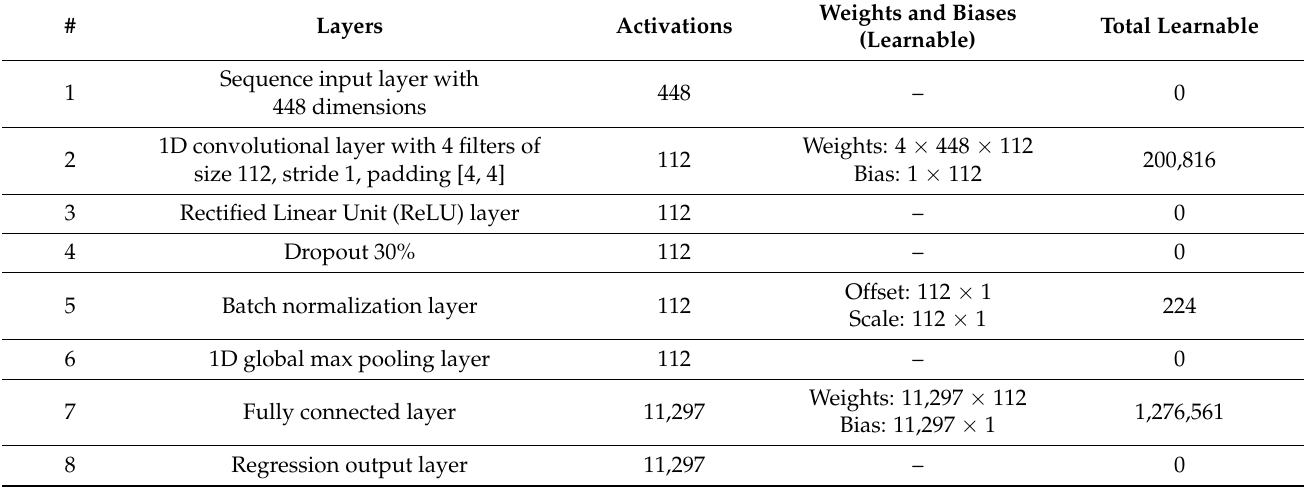
Table 2. Layers of the CNN model.